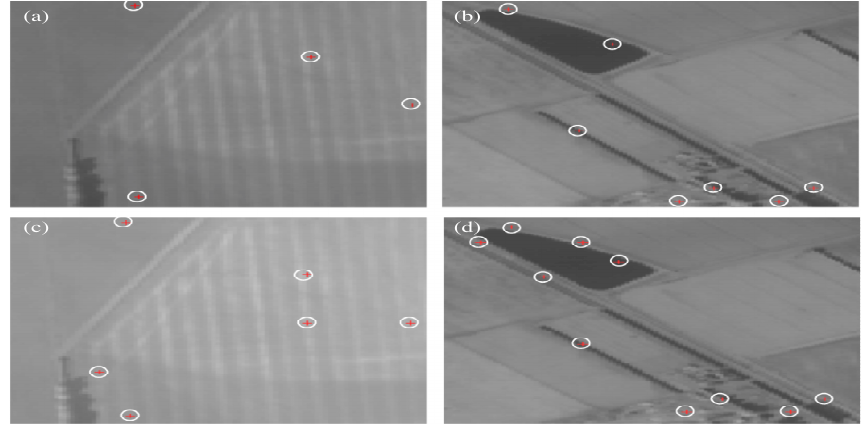
Figure 7. Comparison of CPs: ( a , b ) non-histogram matched image; ( c , d ) the proposed histogram matched